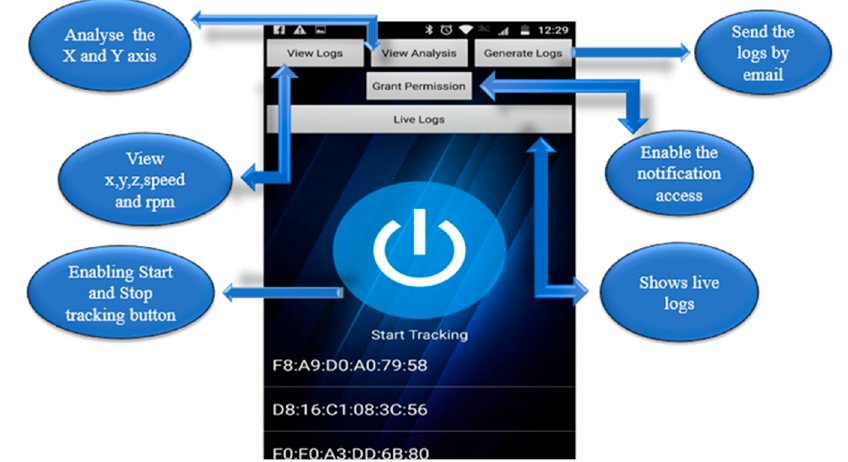
Figure 8 . User interface of the Track User Notification mobile application . Figure 8. User interface of the Track User Notification mobile application.